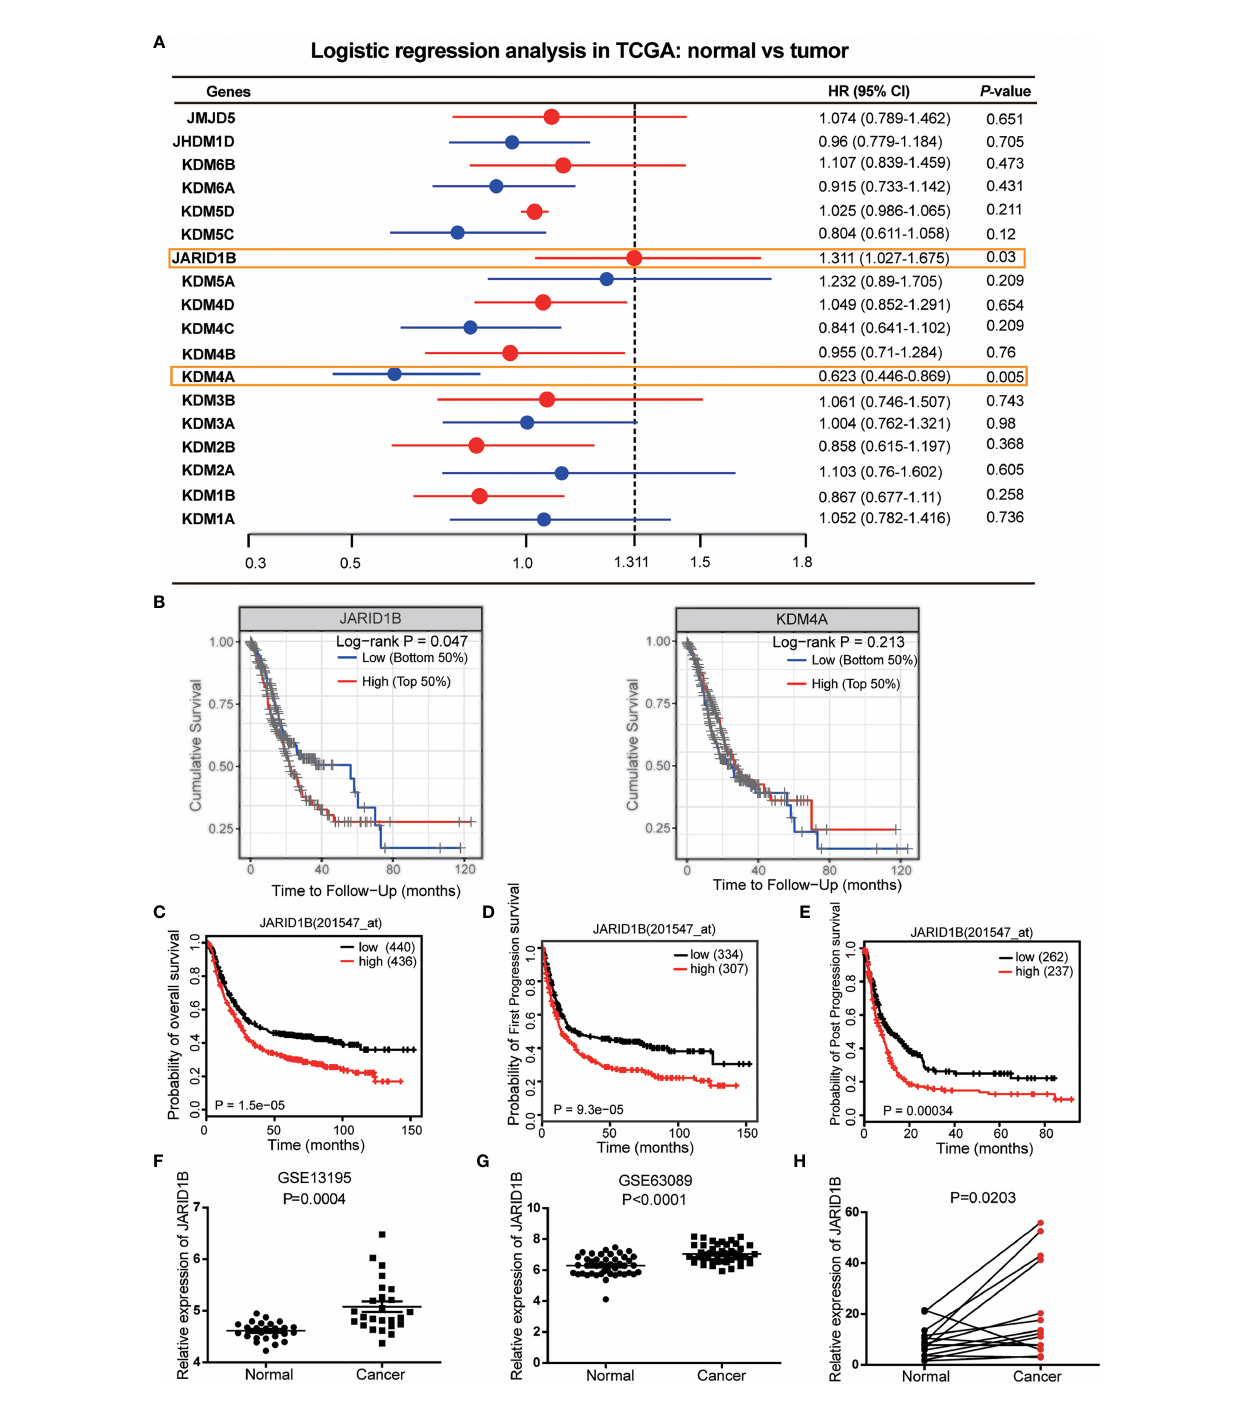
FIGURE 1 | JARID1B overexpression in gastric cancer (GC) patients is associated with poorer prognosis. (A) The logistic regression analysis of 18 histone demethylase gene for the prognosis of GC in The Cancer Genome Atlas (TCGA) database. (B) Further analysis of the prognostic signi fi cance of JARID1B and KDM4A in GC patients. (C – E) Relationship between JARID1B expression and overall survival (C) , fi rst progression survival (D) , the post progression survival (E) in GC patients (log-rank test; n = 876), both data and P values are from the Kaplan – Meier Plotter database. (F, G) GEO RNA sequencing database analysis of the relatively differential expression levels of JARID1B in human GC and paired adjacent normal tissues; the data were derived from GSE13195 (F) and GSE63089 (G) . (H) The messenger RNA (mRNA) levels of JARID1B in 14 GC and paired adjacent normal tissues were measured by real-time PCR (n =